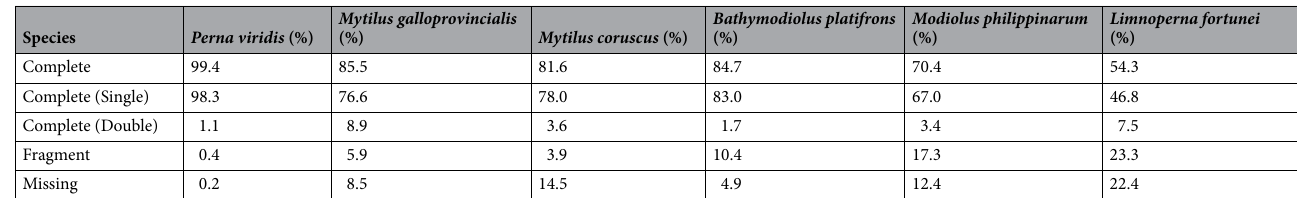
Table 3. Comparison of statistics of BUSCO analysis of the green mussel Perna viridis in the present study with those of other Mytilid mussels reported previously.